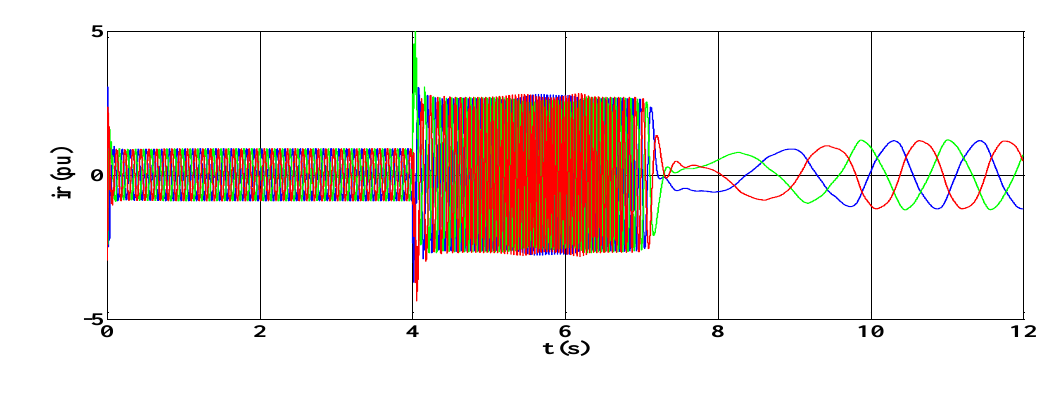
Figure 33. Rotor currents (short-circuit happens at t = 4 s).